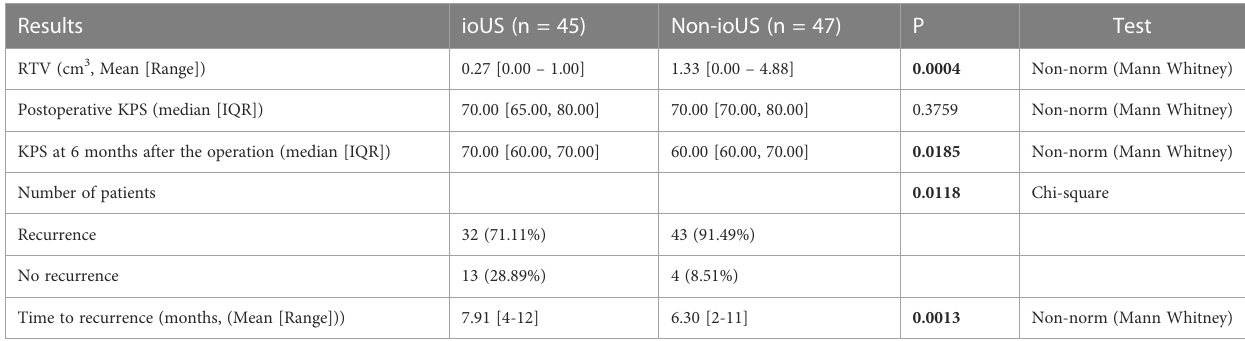
TABLE 3 Outcomes of patients who underwent a second surgery for recurrent gliomas according to ioUS versus non-ioUS. Results